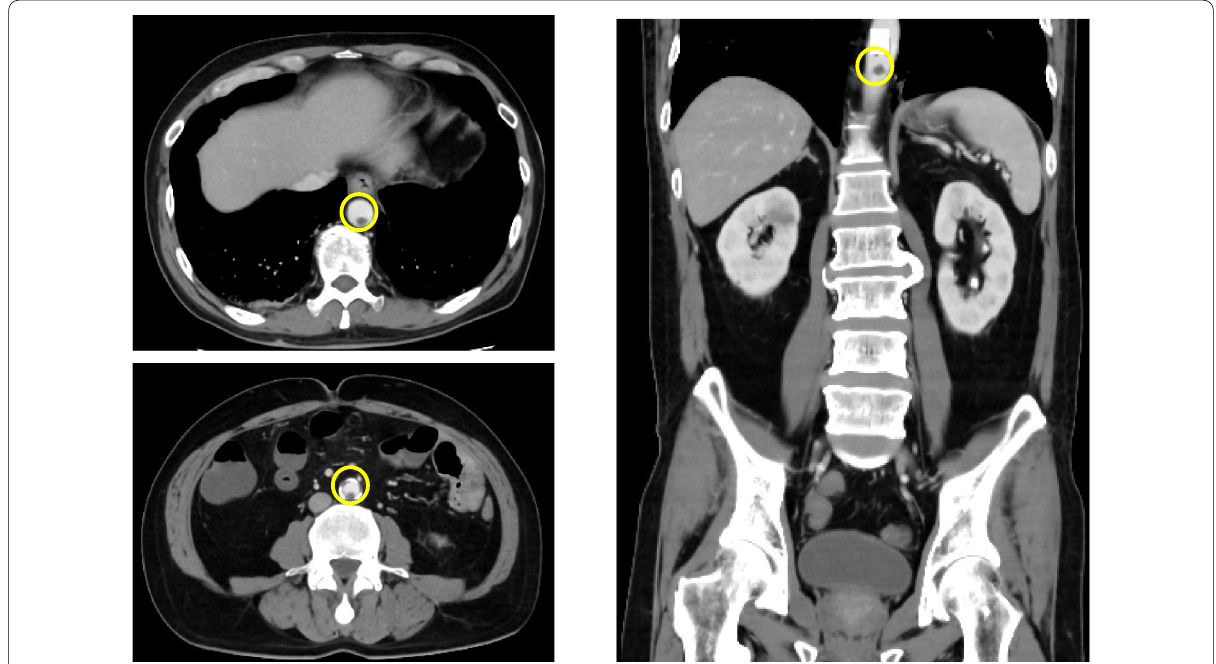
Fig. 1 Abdominal contrast-enhanced CT findings (6th day after hospitalization): Multiple thrombosis from the descending aorta to the abdominal aorta ( ○ ). No obvious evidence of intestinal ischemia was